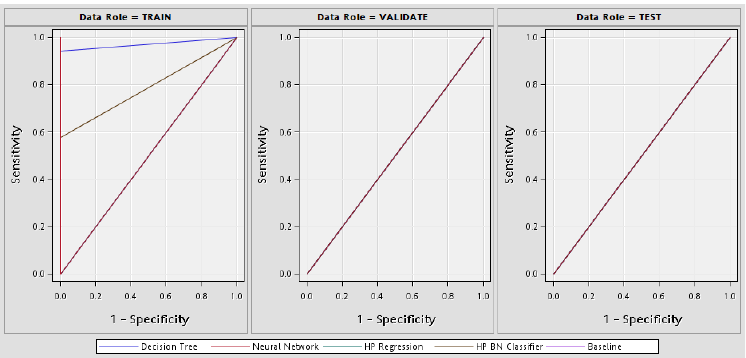
Figure 15. ROC curve comparison results.